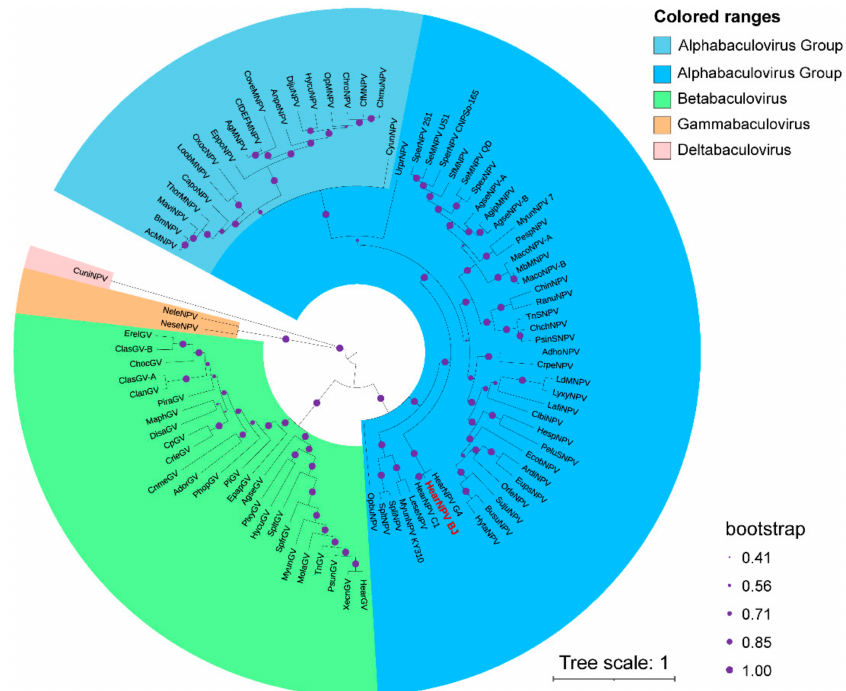
Figure 5. Phylogenetic tree of 91 baculoviruses with complete sequences. The phylogenetic tree was generated using MEGA X software and performed with the maximum likelihood method (bootstrap test 1000 replicates) and a JTT matrix-based model. The result was visualized using iToL